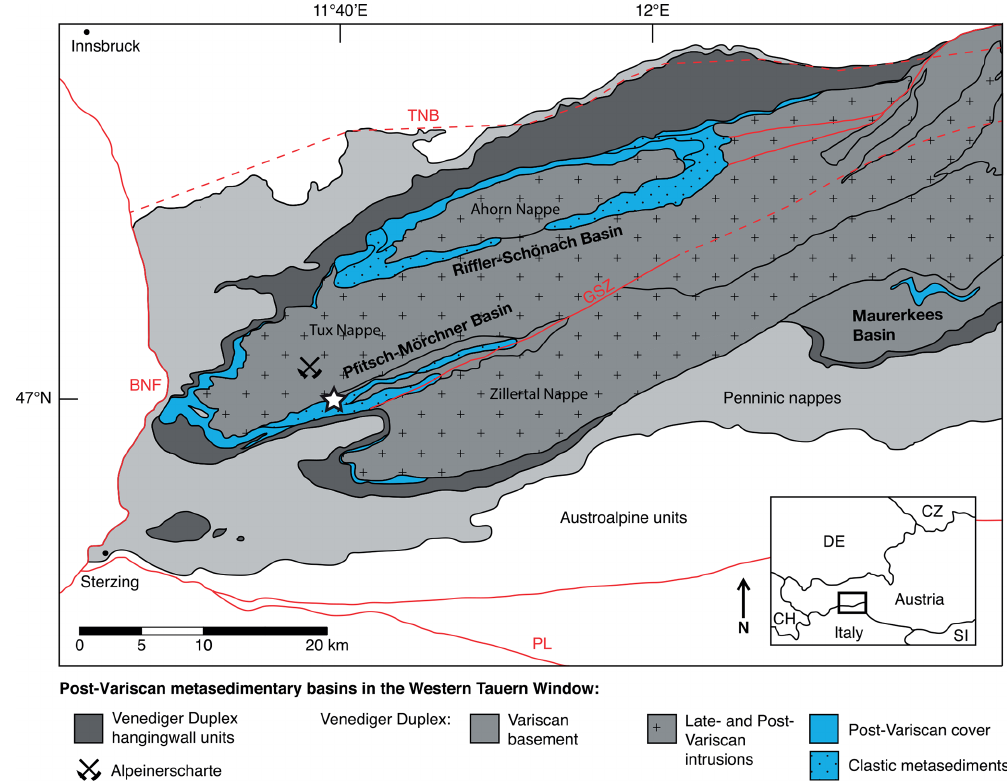
Figure 1. Geological sketch map of the western Tauern Window (inset shows the location at the Italian–Austrian border), highlighting the post-Variscan metasedimentary basins. Star indicates position of the schematic sedimentary profiles (Fig. 2), and the mine symbol indicates “Alpeinerscharte”, the location of the abandoned molybdenite mine. Modified from Lammerer et al. (2008) and Veselá et al. (2008). Abbreviations: TNB, Tauern North Boundary Fault; BNF, Brenner Normal Fault; PL, Pustertal Line, part of the Periadriatic Lineament; GSZ, Greiner shear